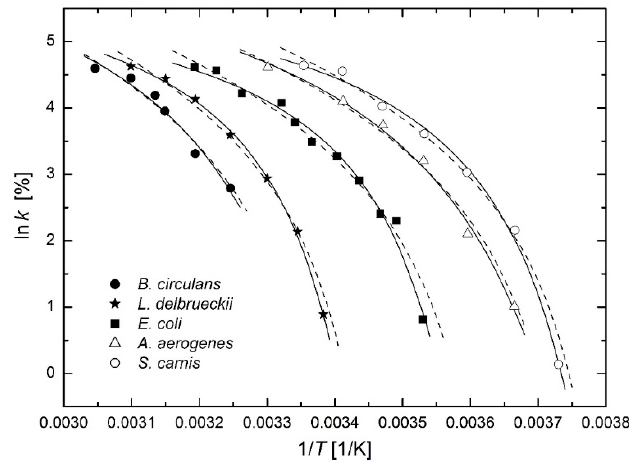
Figure 12. Arrhenius plots for the relative growth rates of bacterial cultures [28,29] based on the modified Arrhenius Equation (23) (solid lines) and on phenomenological regression function (29) (dashed lines). See Table 4 for full names of bacterial cultures.